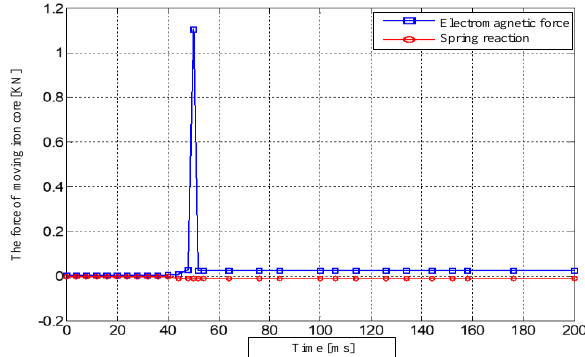
Figure 17. Dynamic core and spring force changing with time curve.